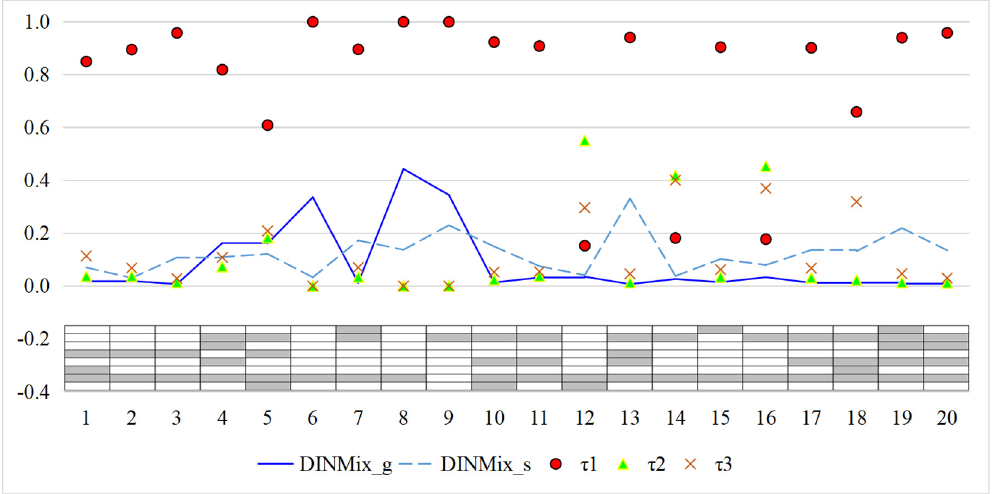
Figure 9. The estimated item parameters for the fraction subtraction data from the DINMix models. Note: g = guessing parameter; s = slip parameter; τ 1 = item-level mixing proportion parameter for the conjunctive condensation rule; τ 2 = item-level mixing proportion parameter for the disjunctive condensation rule; τ 3 = item-level mixing proportion parameter for the ratio condensation rule; DINMix = deterministic input, noisy mixed model.